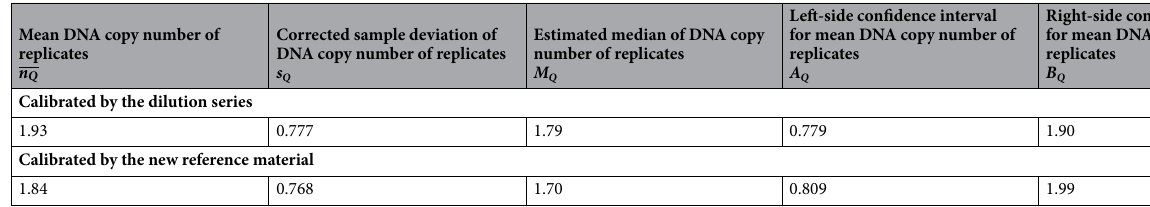
Table 5. Real-time PCR results of target samples to be quantified excluding undetermined